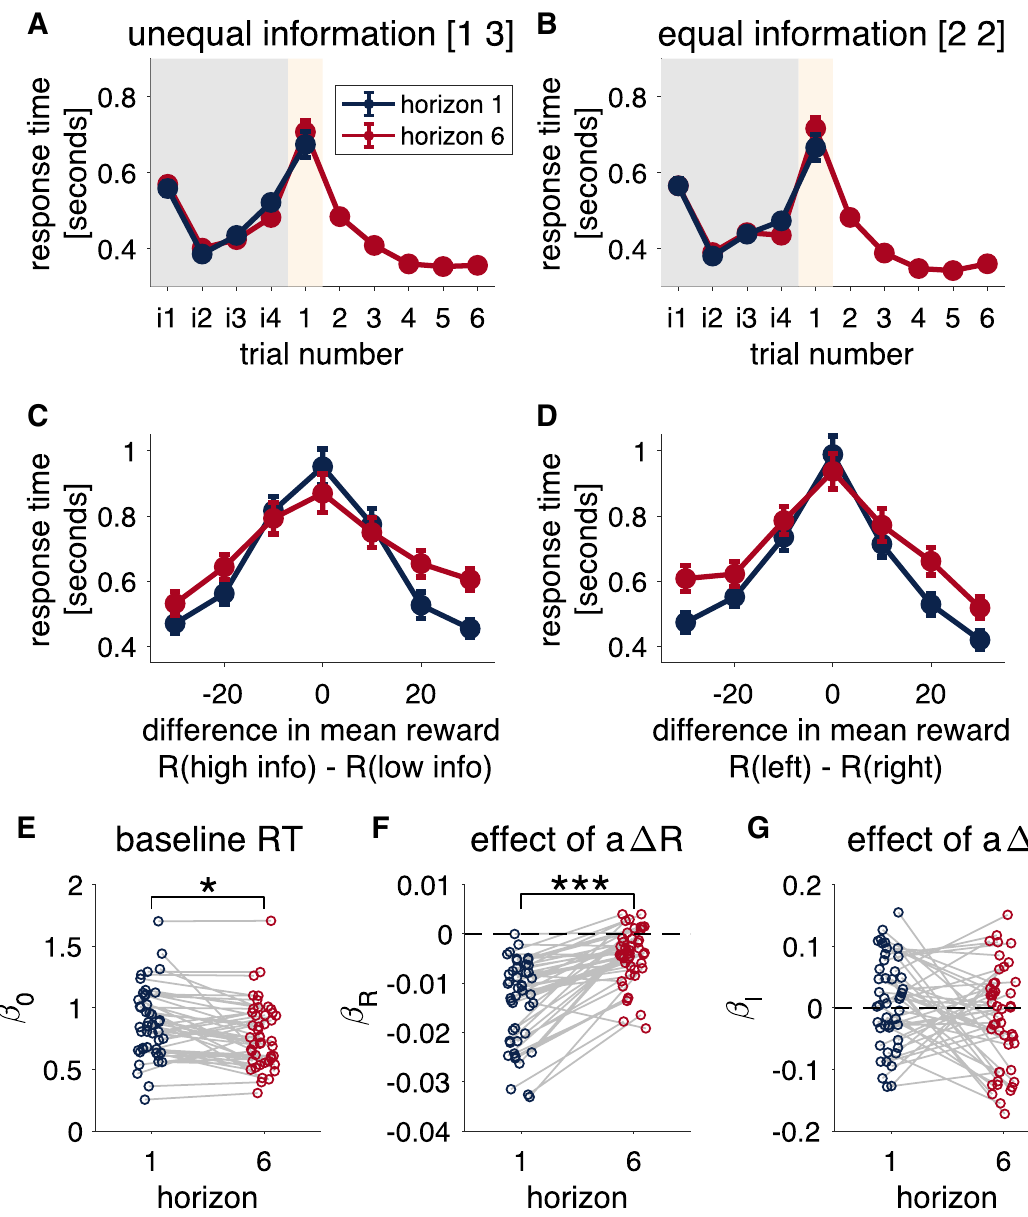
Figure 4. Response times in the Horizon Task. ( A , B ) Average response time as a function of trial number for the unequal ( A ) and equal ( B ) information conditions. Instructed trials are labeled i1-4, free-choice trials 1–6. ( C , D ) Response time as a function of difference in mean observed reward in the unequal ( C ) and equal ( D ) information conditions. ( E , F G ) Linear regression analysis showing the baseline response time ( E ), and the effects of a (cid:31) R ( F ), and a (cid:31) I ( G ) on response